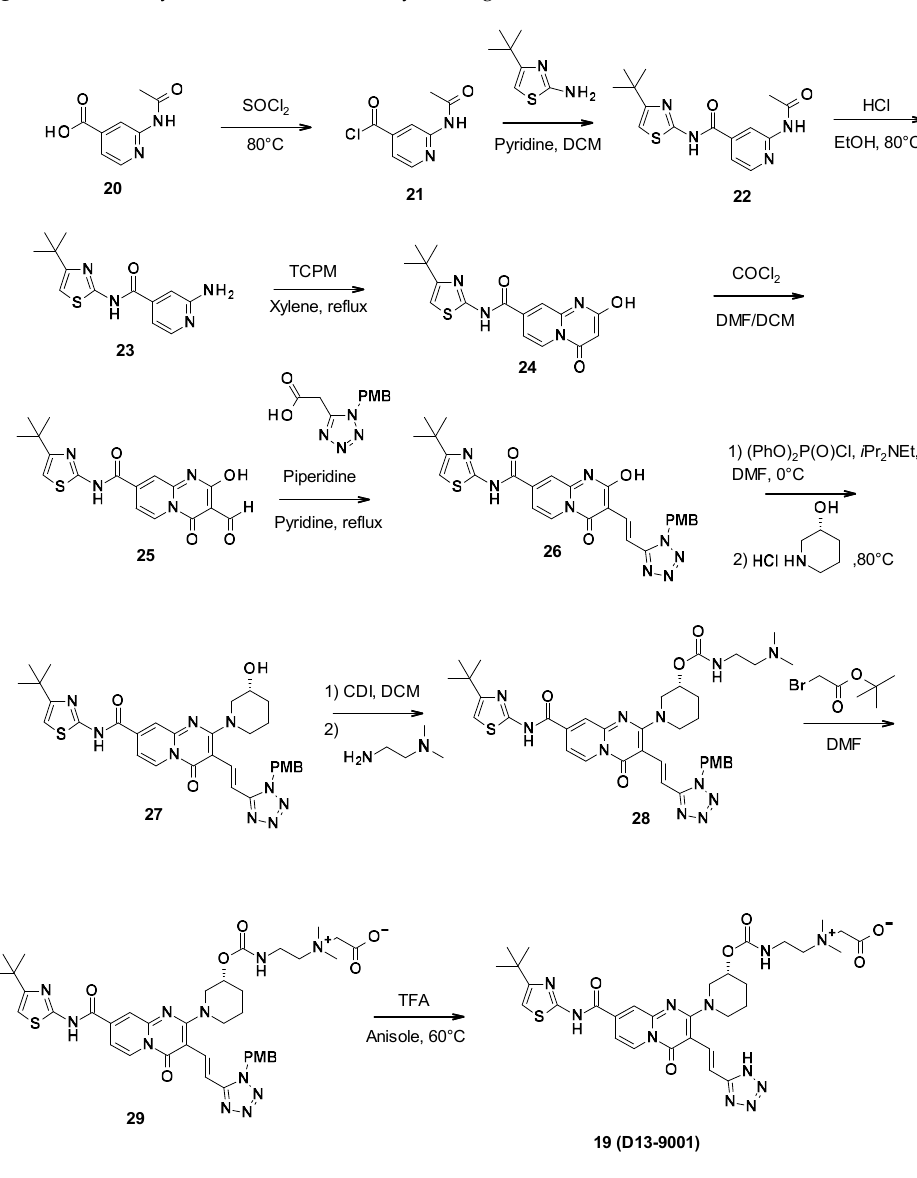
Figure 5. Summary of the structure–activity leading to D13-9001.